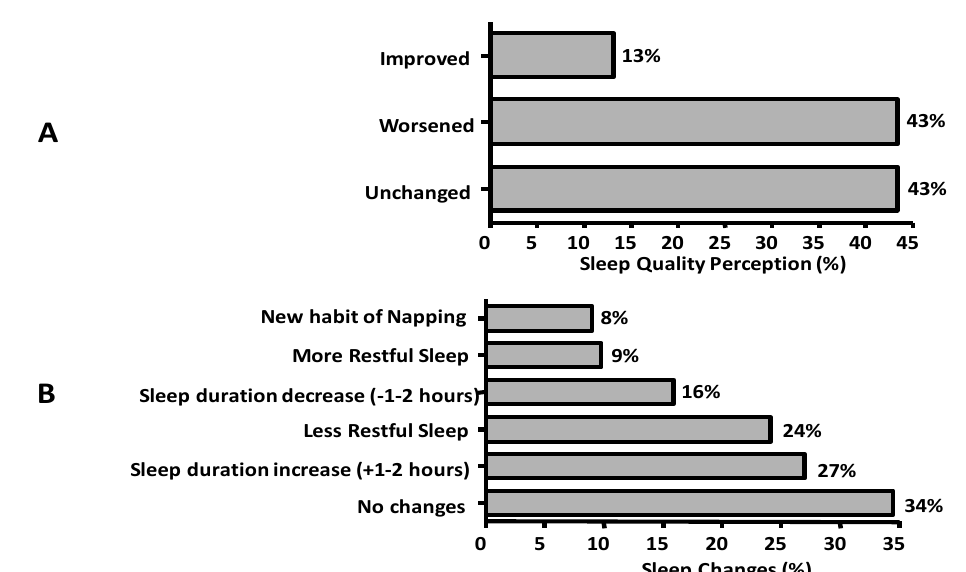
Figure 1. Frequencies of perceived quality of sleep ( A ) and of changes in sleep duration and feeling of restful sleep ( B ).